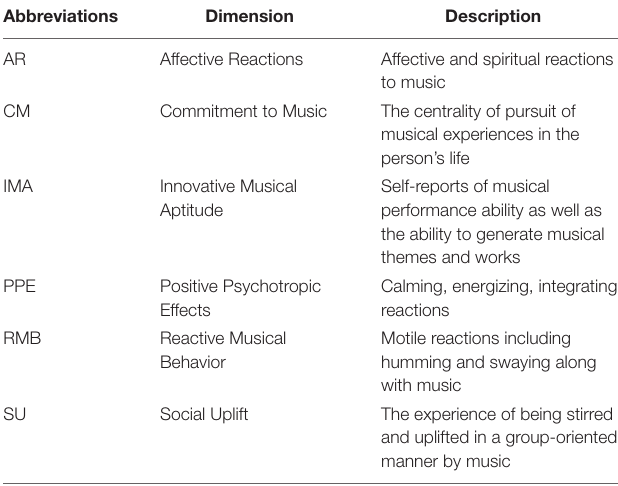
TABLE 1 | Brief Music Experience Questionnaire (BMEQ)